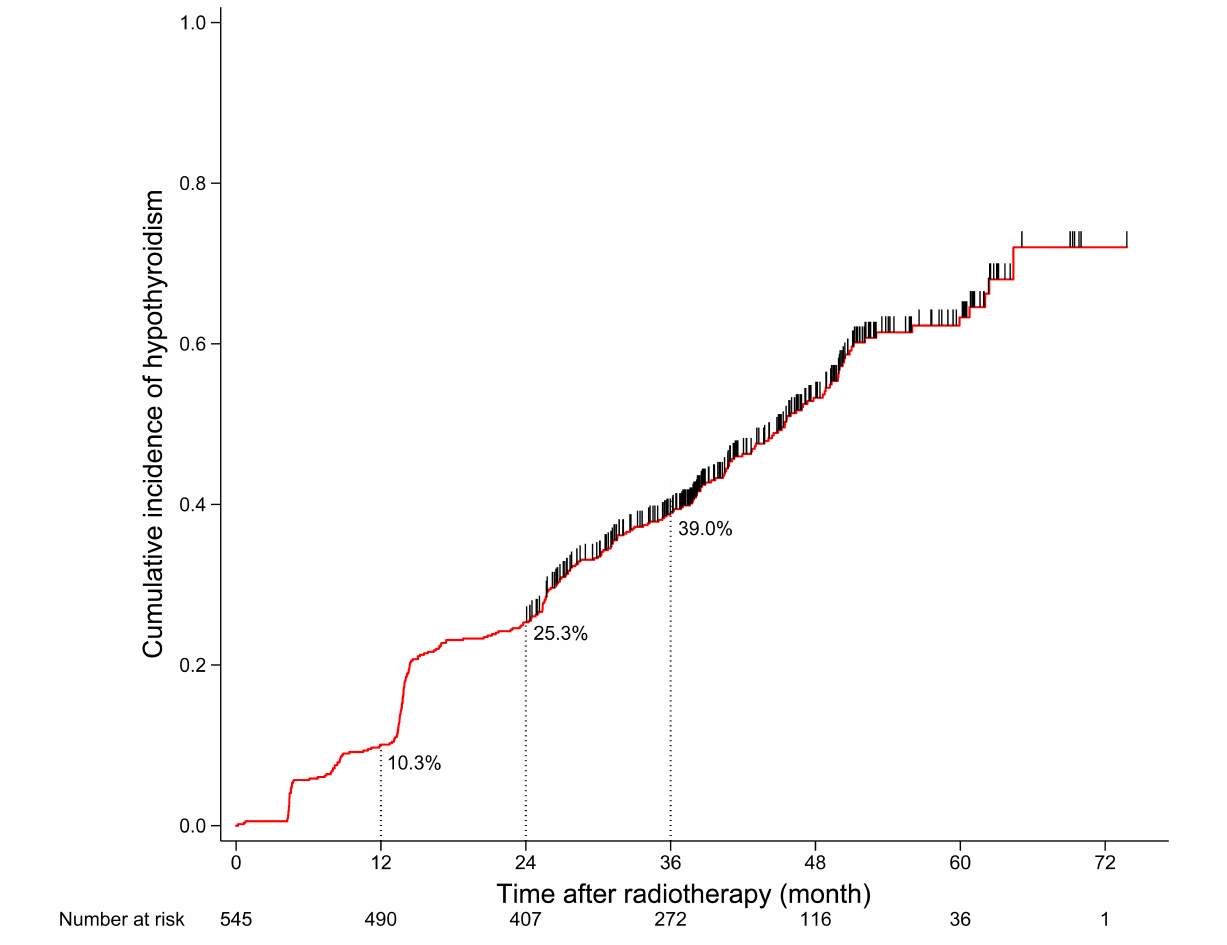
Frontiers in Oncology |